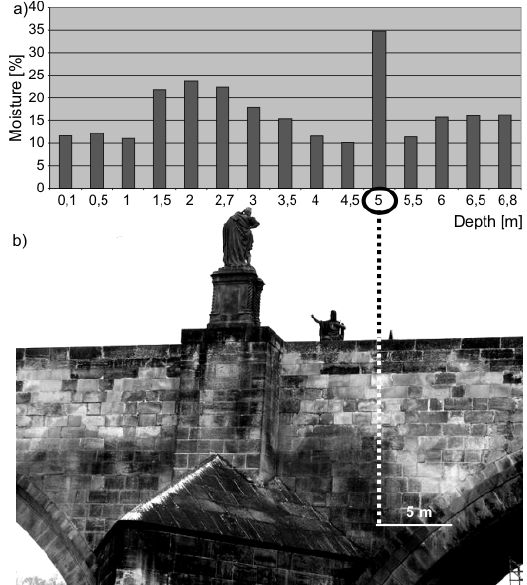
Fig 10. Moisture content-core hole depth relation (VJ 2) in arch III: a) moisture content of building materials de- termined by core holes; b) visually observable manifesta- tions of increased moisture on breast wall surface